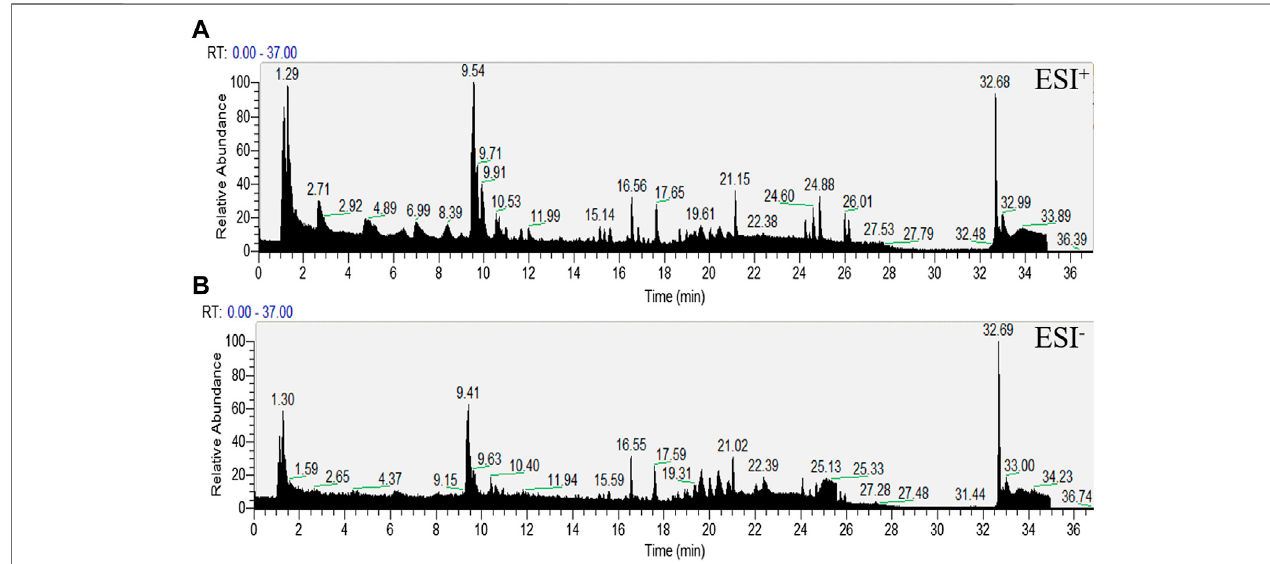
FIGURE 4 | Representative total ion chromatograms (TIC) obtained in serum in ESI+ and ESI- modes.